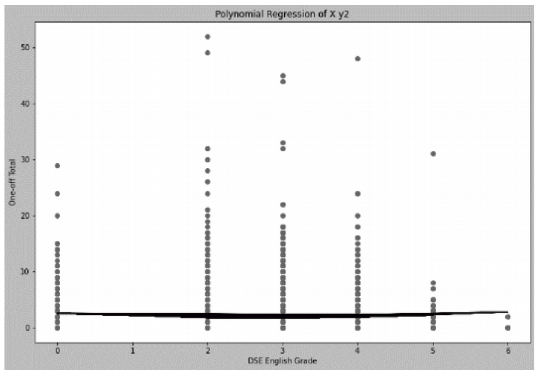
Figure 20. Polynomial Regression of X y2 in Finding